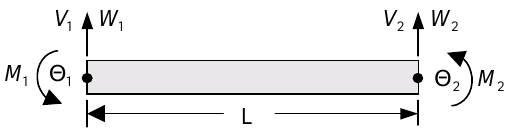
Fig. 2. Sign convention for the spectral Timoshenko-beam